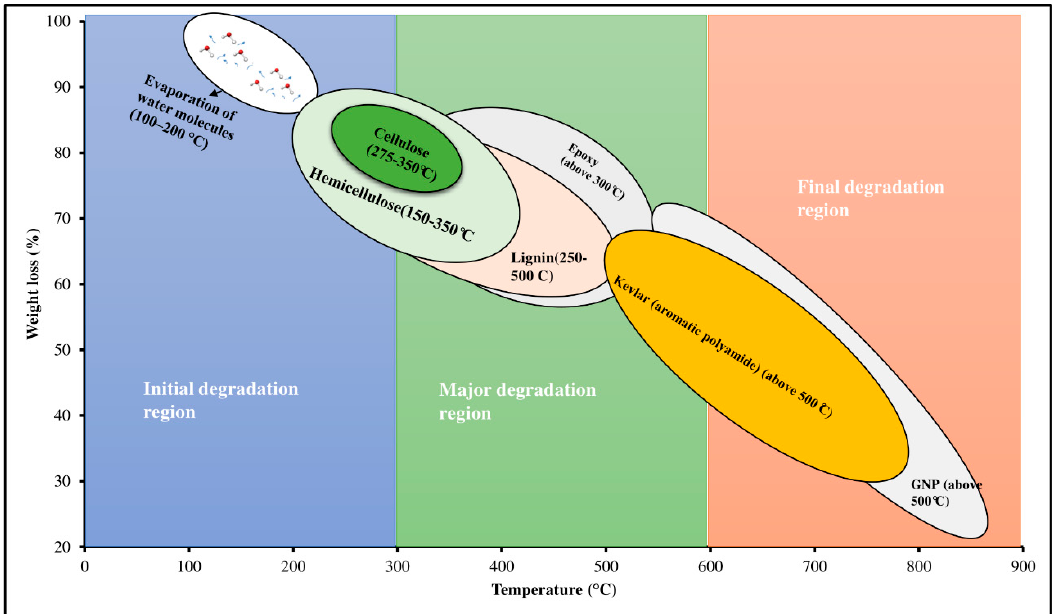
Figure 5. Graphical representation of thermal degradation pathway of Kevlar/ Cocos nucifera sheath (CS)/GNP epoxy hybrid composite. Table 2. Thermal degradation and char residue of different wt.% of Kevlar/CNS composites.